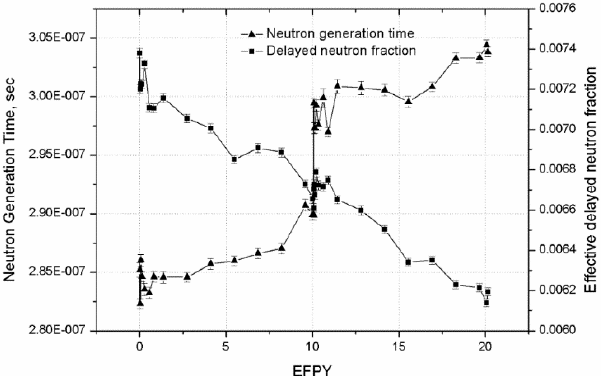
Figure 13. Kinetic parameters of the MMR core.